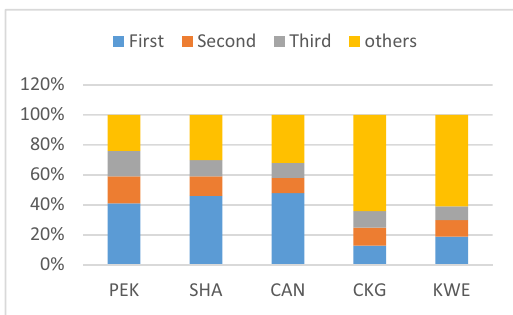
Figure 2: Proportion of airline fl ights in some main hub airports in